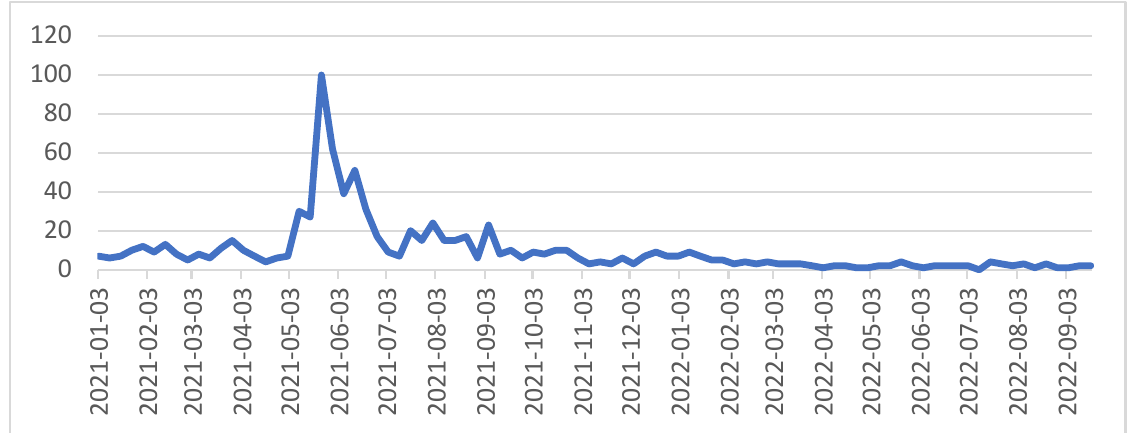
Figure 2. “Wuhan Lab” keywords Google trends.